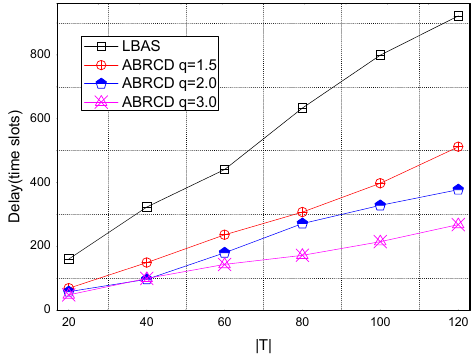
Figure 39. The impact of | T | with fixed network size = 400 on delay.